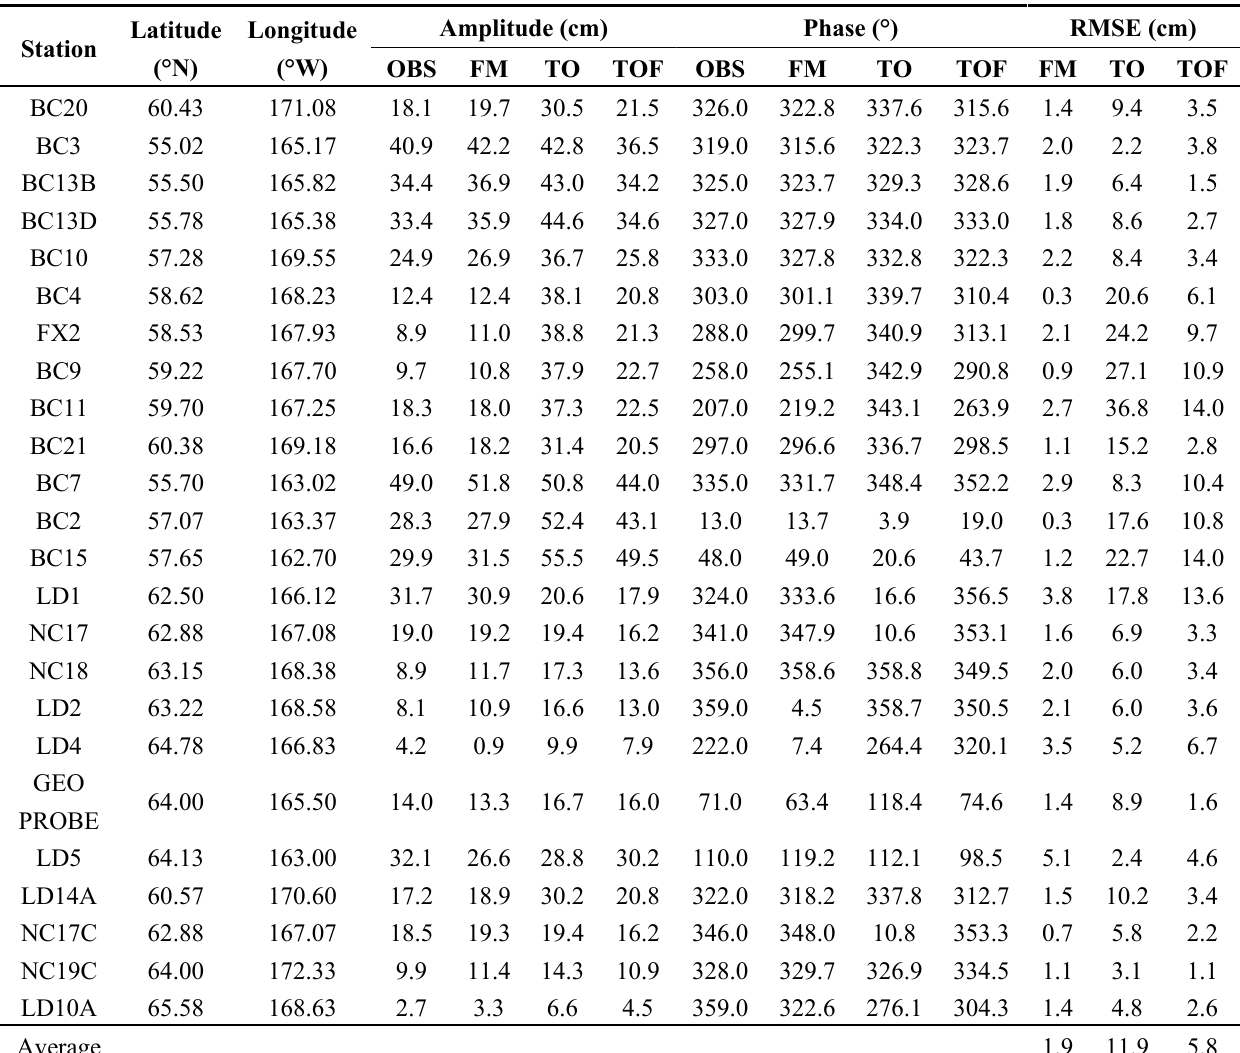
Table 3. Comparisons of K1 amplitude and phase at the literature stations between OBS, FM, TO and TOF. The acronyms have been described in the